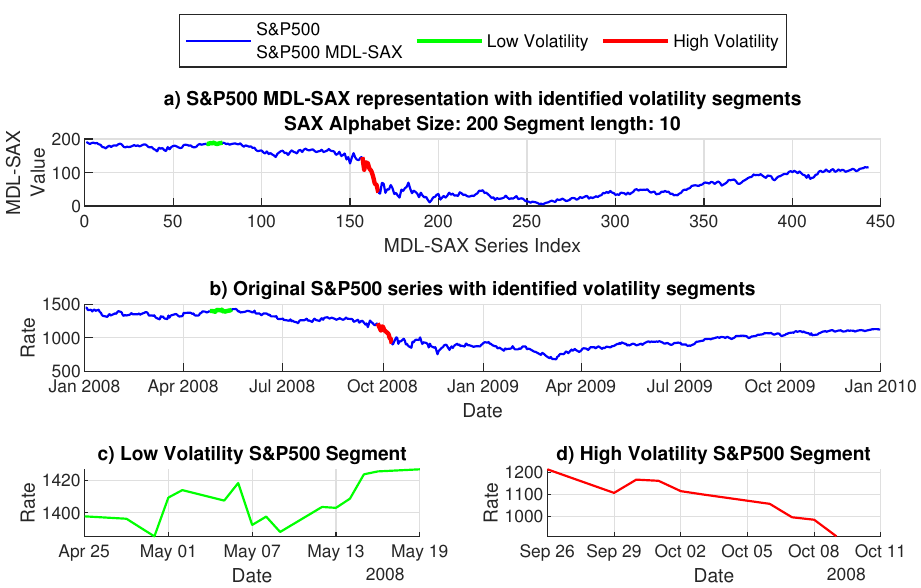
Figure 11. S&P500 MDL-SAX representation ( a ) with identified high/low volatility segments. For clarity, the original S&P500 series from January 2008 to January 2010 is shown in ( b ), with isolated low ( c ) and high ( d ) volatility segments. SAX Alphabet size = 200, Num of SAX segments = series length, MDL-SAX segment length =